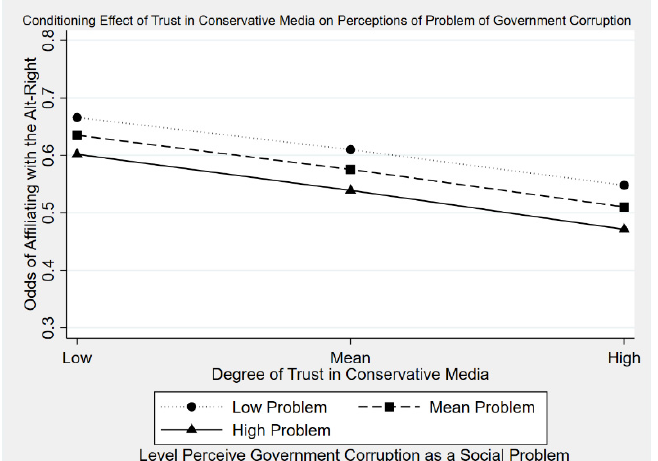
Figure 5. Conditioning Effect of Conservative Media: Government Corruption and the Alt-Right.